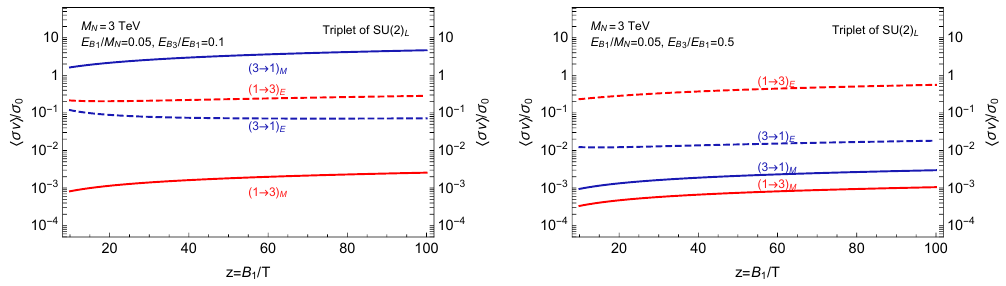
Figure 1 . Thermally averaged cross sections as a function of the temperature z = E B =T . The rates are decomposed per channel and per type (magnetic M , and electric E